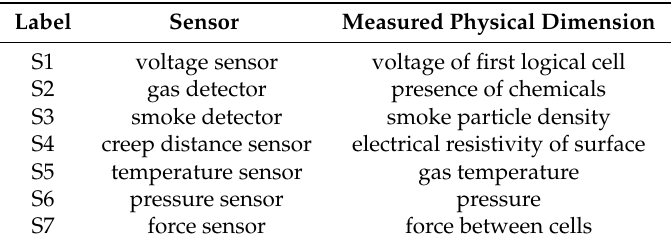
Table 1. Overview over the investigated sensor set. All sensors deliver a voltage output signal or can easily be transformed into one by a voltage